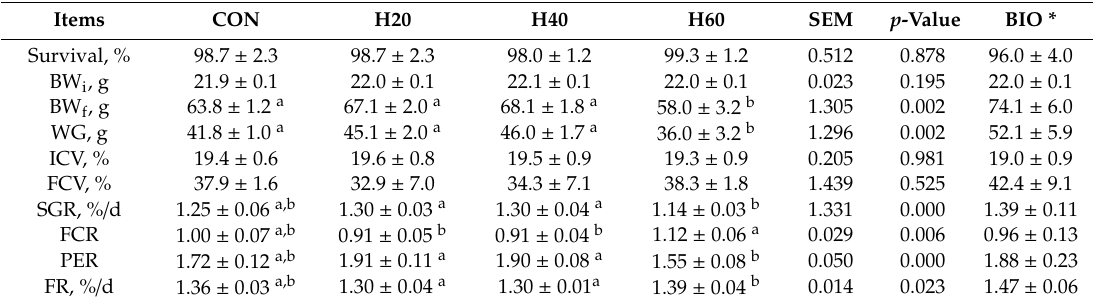
Table 4. Survival and growth performance of Eurasian perch fed experimental diets and the commercial control diet (mean ± SD; n =